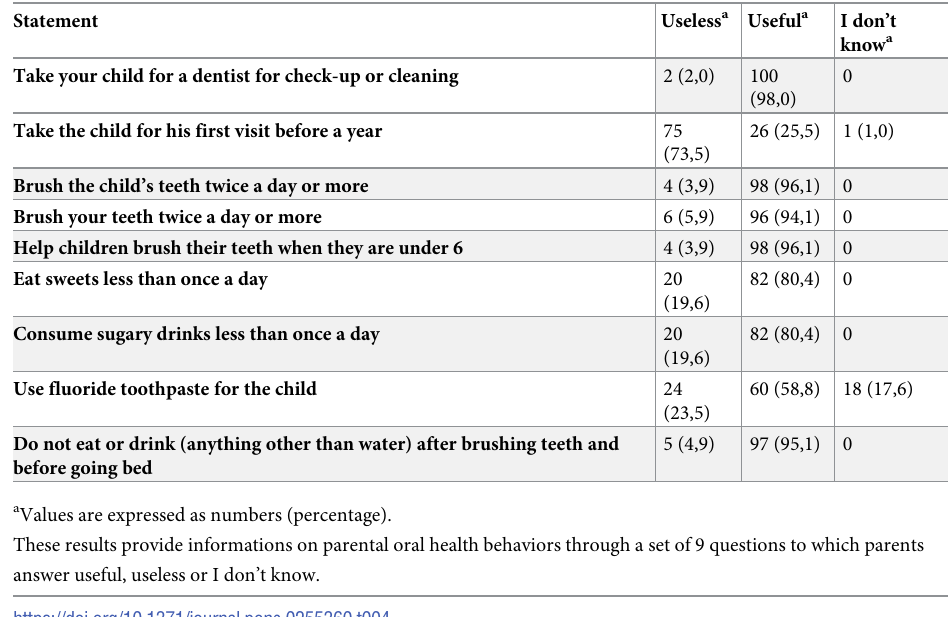
Table 4. Parental oral health